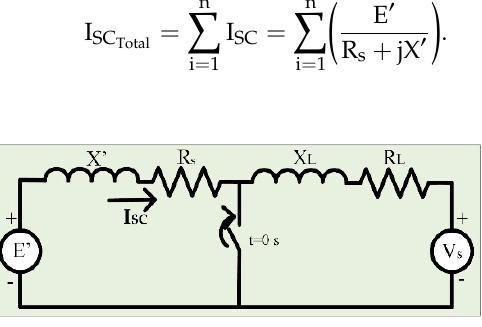
Figure 5. Sequence network circuit for three-phase fault.